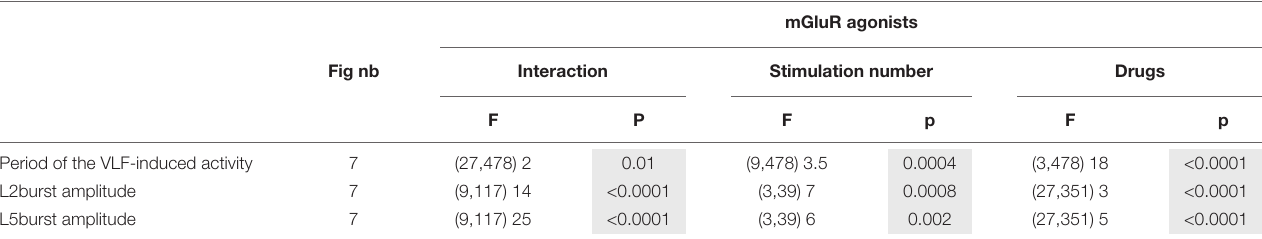
TABLE 6 | Results of the Kruskal–Wallis tests performed to analyze the effects of the metabotropic glutamate receptor (mGluR) agonist (drugs) across series of 10 stimulations (stimulation number) applied to the ventrolateral funiculus (VLF) axons on the period of the VLF-induced fictive locomotion as well as lumbar 2 (L2) and L5 motor burst amplitudes.